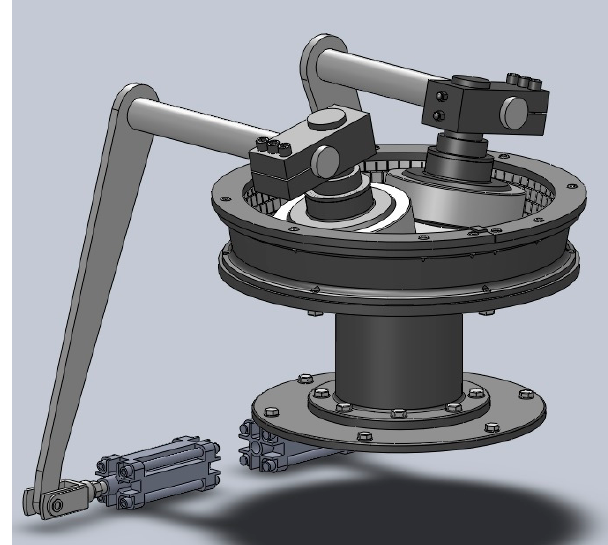
Figure 5. Diagram of regeneration device from Omega Foundry Machinery Ltd.